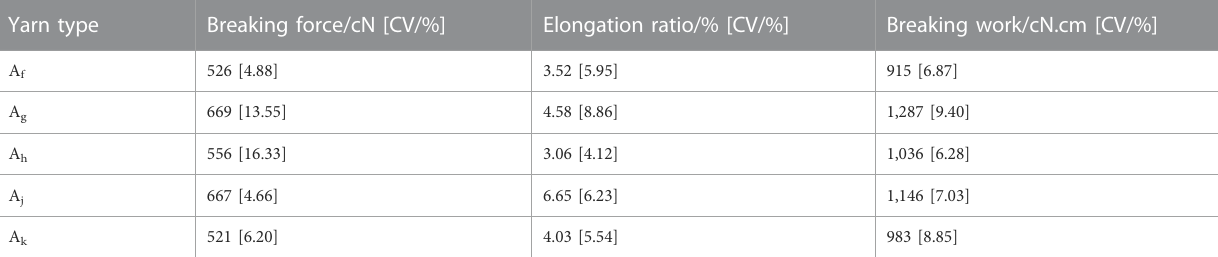
TABLE 4 Tensile properties of different composite yarns. Yarn type